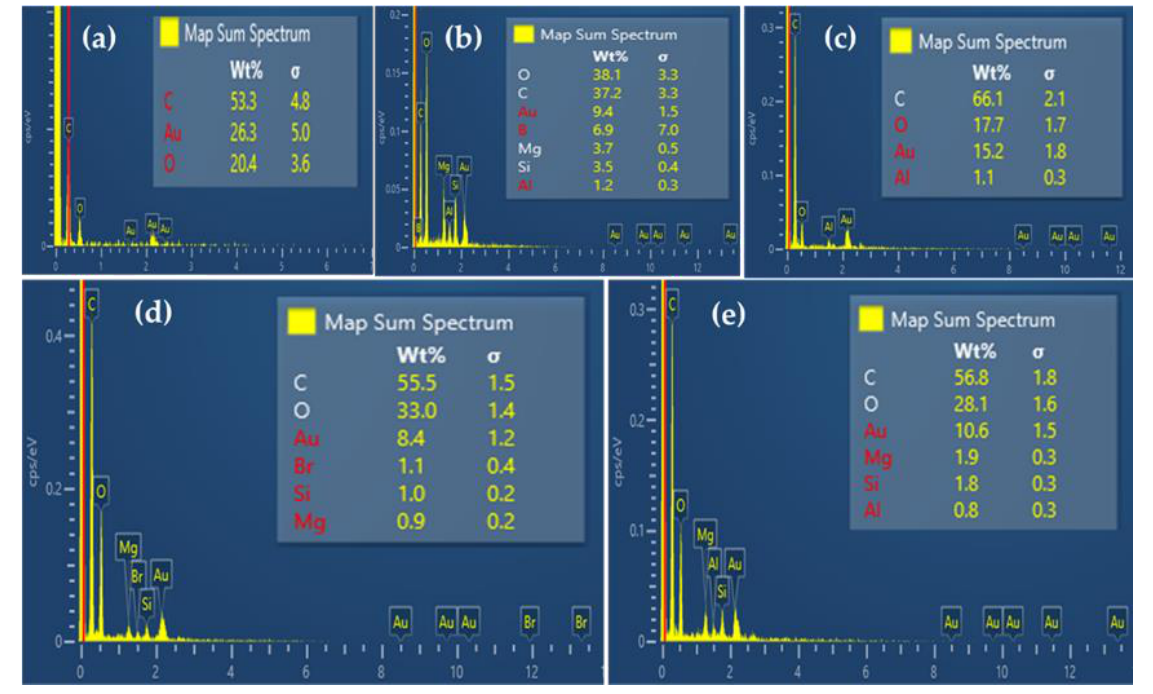
Figure 5. EDS profile of composites: PU/VMT 0% ( a ), PU/VMT 5% ( b ), PU/VMT 10% ( c ), PU/VMT 15% ( d ), and PU/VMT 20% ( e ).